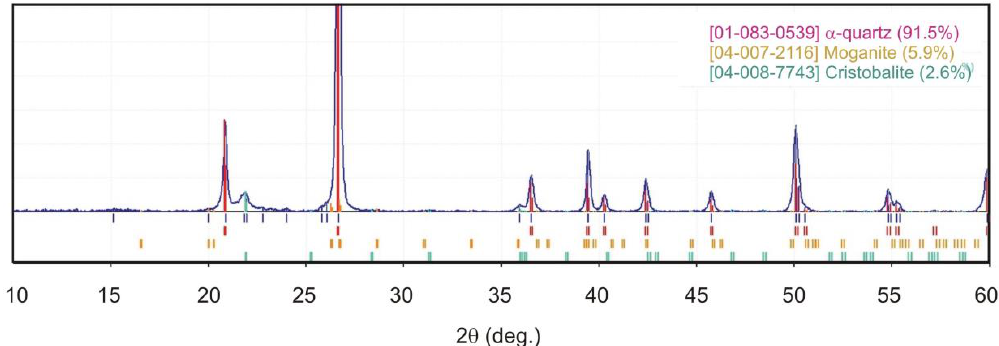
Figure 18. X-ray diffraction pattern of the studied sample (agate No. 4) (CuK α radiation). Figure 18. X-ray di ff raction pattern of the studied sample (agate No. 4) (CuK α